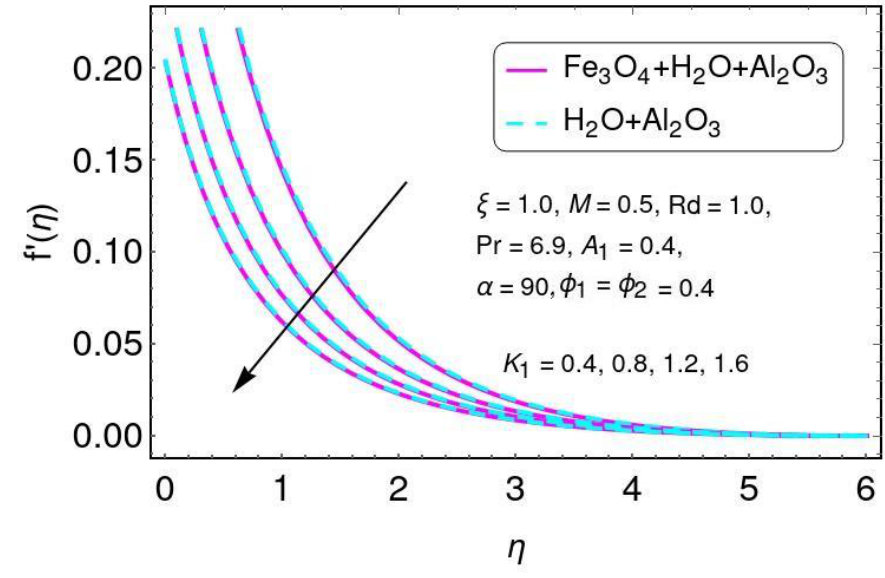
Figure 10. The distribution of f (cid:48) ( η ) for K 1 .